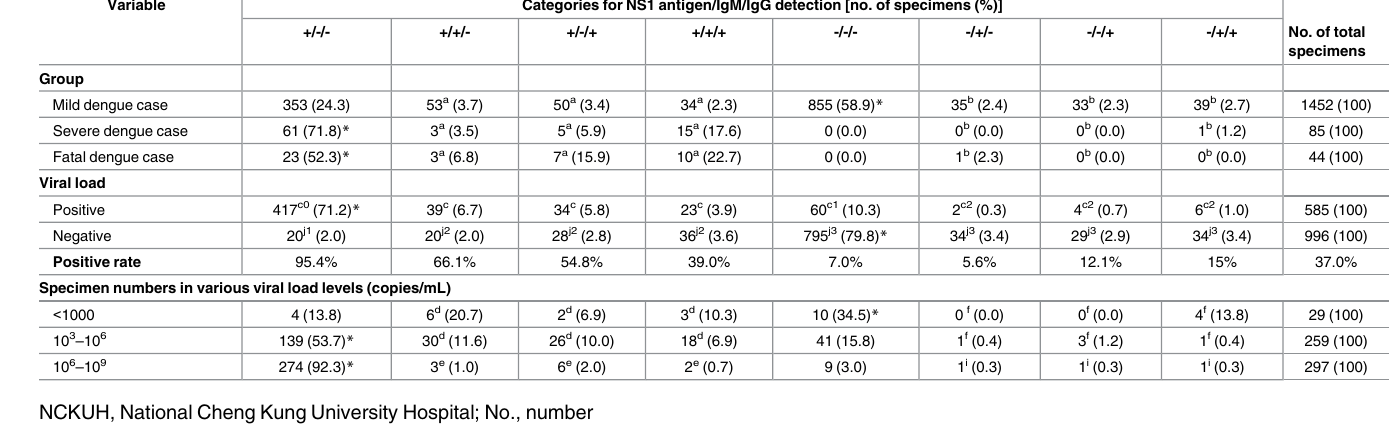
Table 3. Comparison of viral load levels between various NS1 antigen, IgM, and IgG categories at NCKUH.